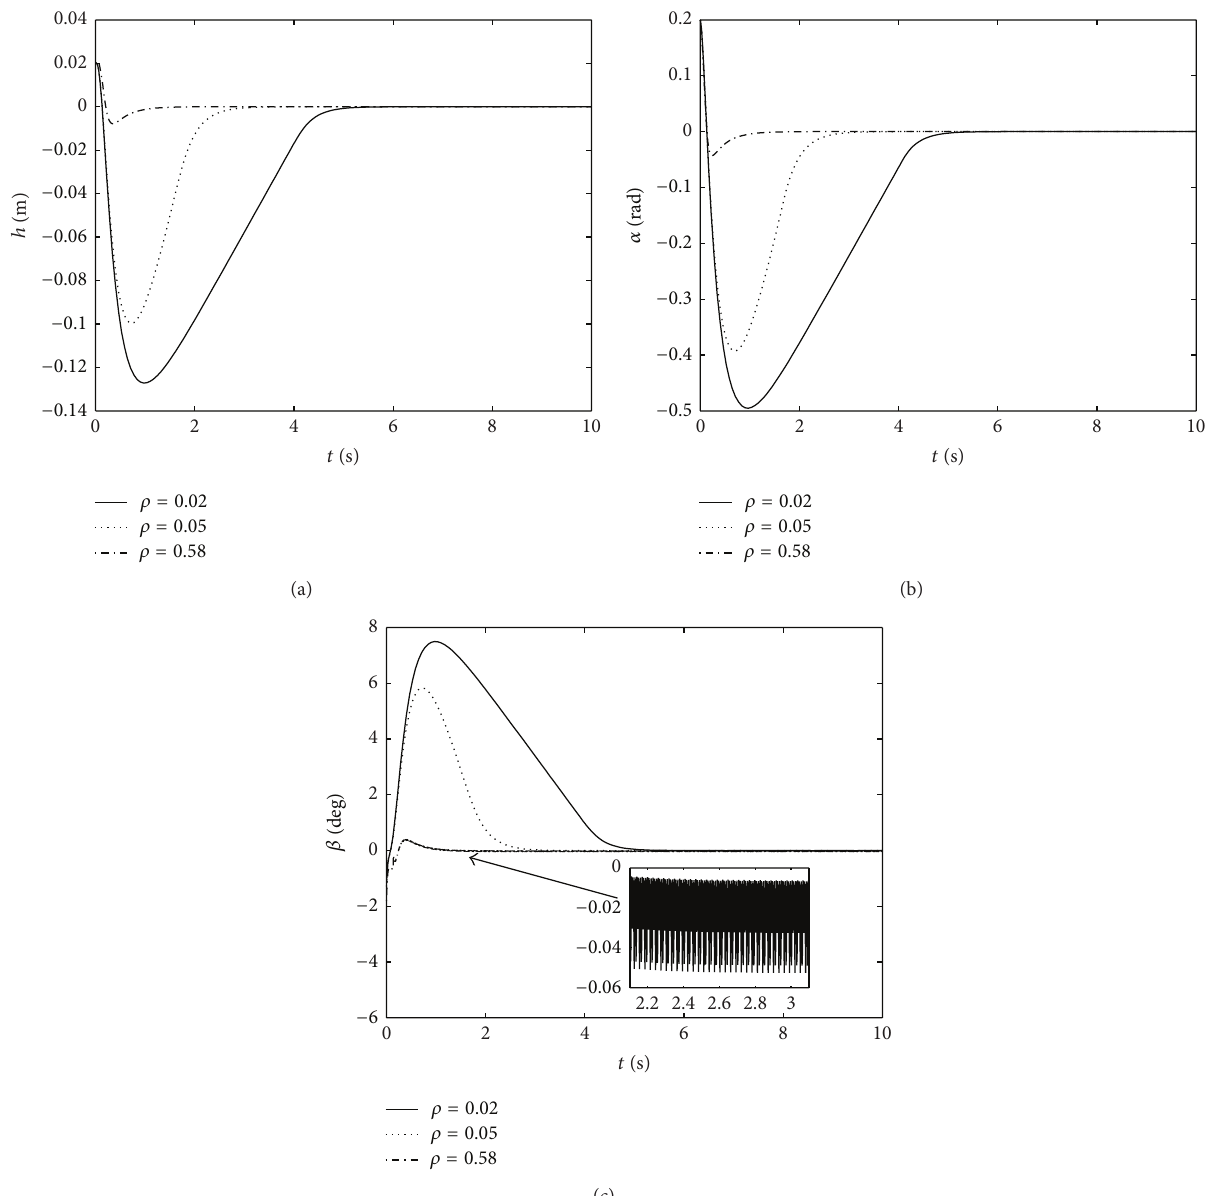
Figure 5: Nonlinear flutter control: 𝑈 = 13 m/s, 𝜀 = 0.009 . (a) Plunge. (b) Pitch. (c) Control input.